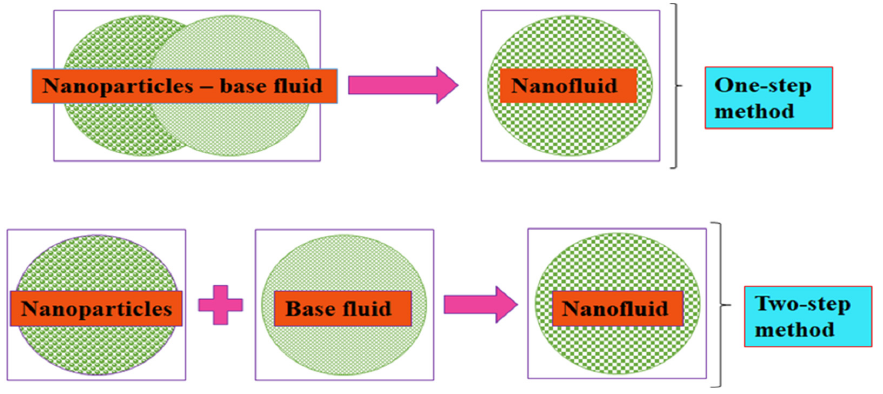
Figure 2. Mono and hybrid NF formulation strategies.